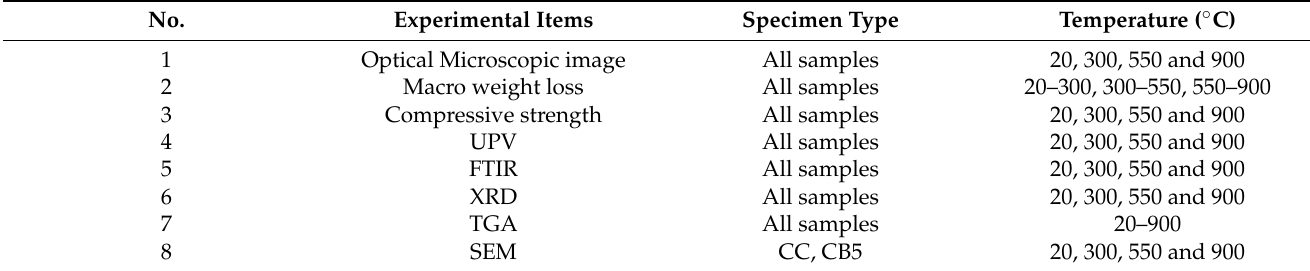
Table 3. Experimental items and specimen